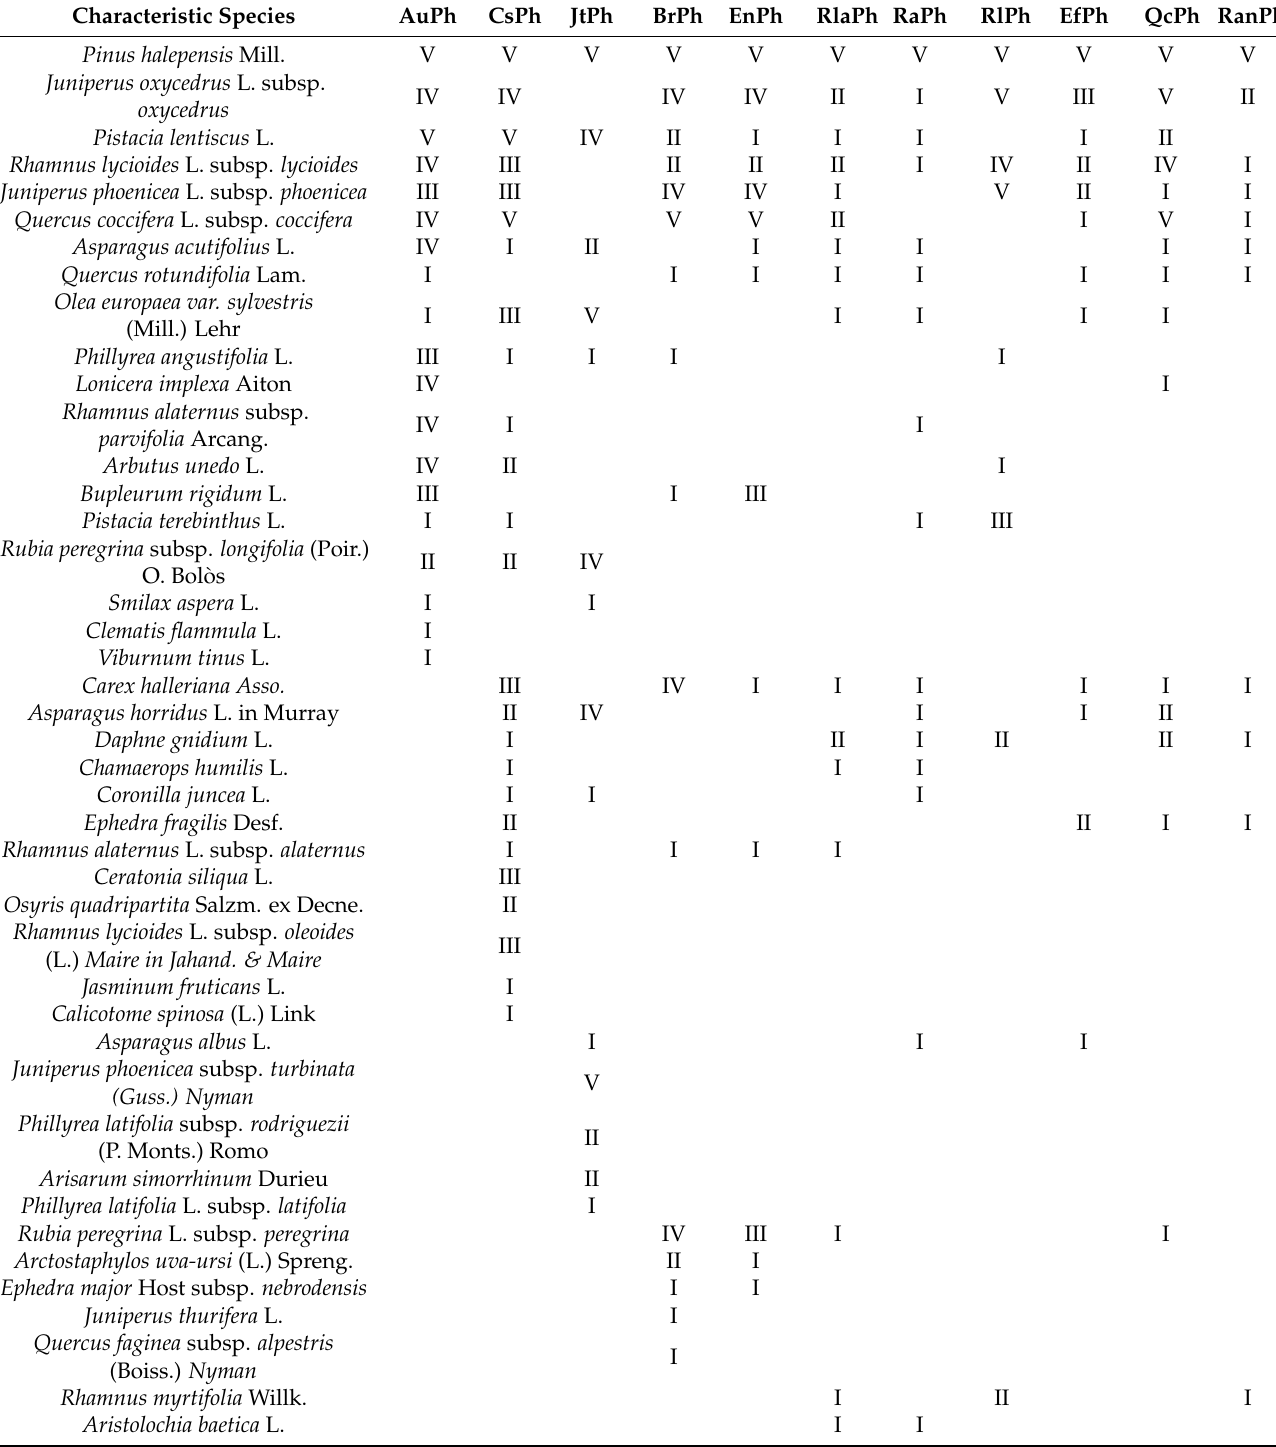
Table 4. Synthetic table of the association in the study. AuPh. Arbuto unedonis-Pinetum halepensis